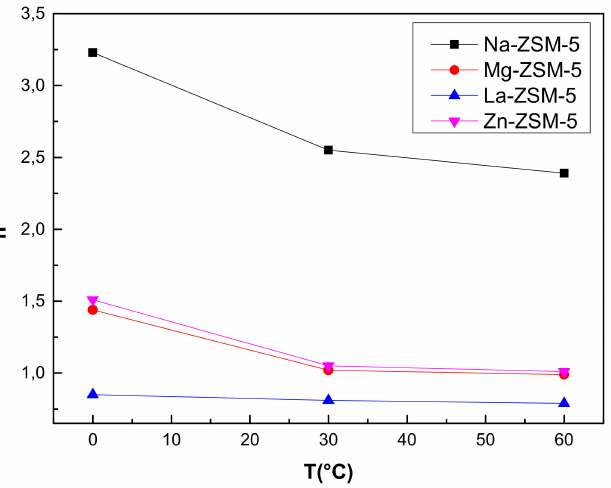
Figure 5. Effect of temperature on the number of CO 2 molecules captured on the Na-ZSM-5, Mg-ZSM-5, La-ZSM-5 and Zn-ZSM-5